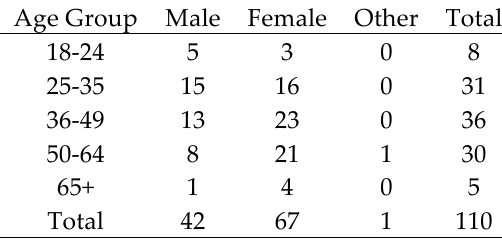
Table 1. Reported Demographic Data of PLWD Survey Participants Age Group